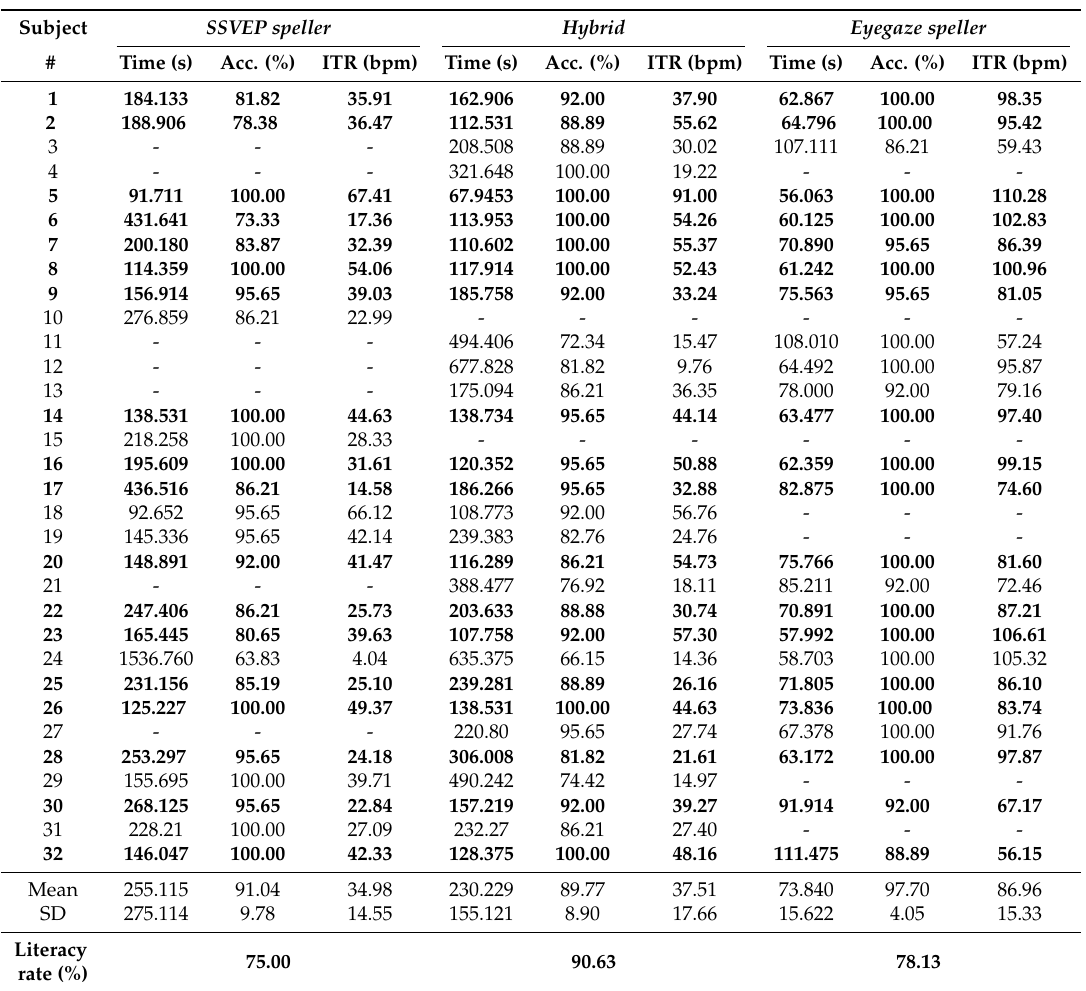
Table 2. Results from the copy spelling task of all three tested applications: the steady-state visual evoked potentials based application ( SSVEP speller ), the here presented Hybrid application, and the eye tracking based application ( Eyegaze speller ). Participants that were not able to successfully control a spelling interface were excluded from the calculation of mean values for that particular system. The 18 participants who completed the tasks with all three applications are highlighted